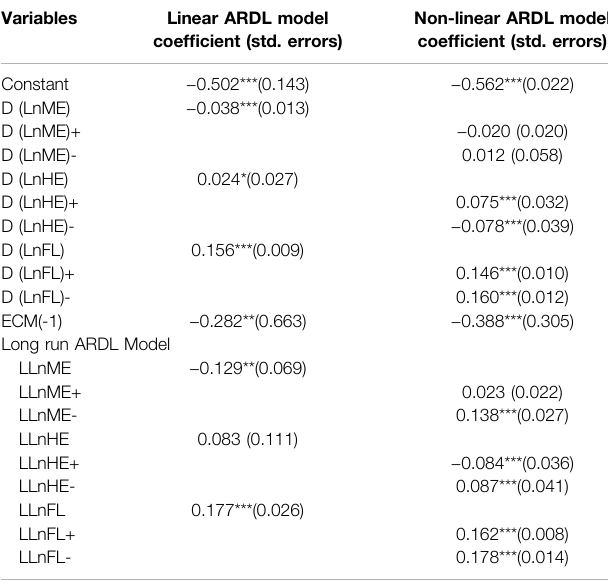
TABLE7| Shortrunandlongrunestimatesbasedontheselectedlinearandnon- linear ARDL Model.